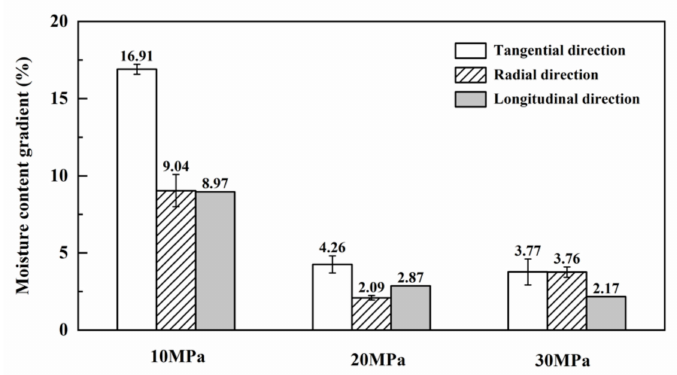
Figure 6. Moisture content gradient of wood after 1 h of SCD at di ff erent